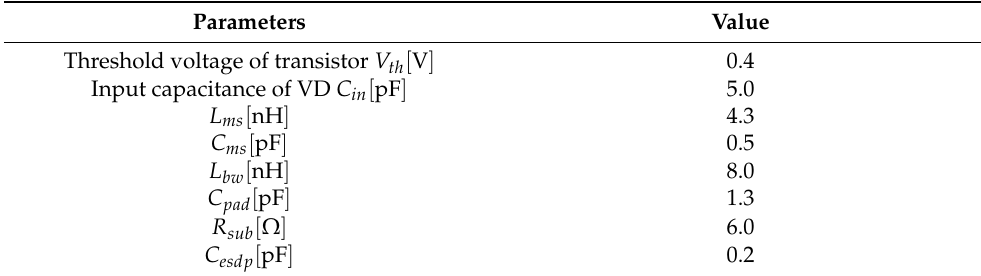
Table 2. Various parameters used in the demonstration.